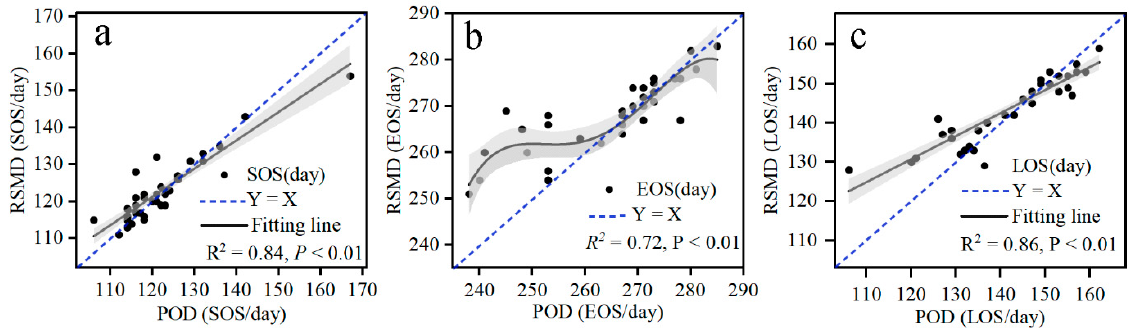
Figure 4. The comparison between remote sensing monitoring data (RSMD) and phenological observation data (POD): ( a ) start of the growing season (SOS); ( b ) end of the growing season (EOS); ( c ) length of the growing season (LOS).